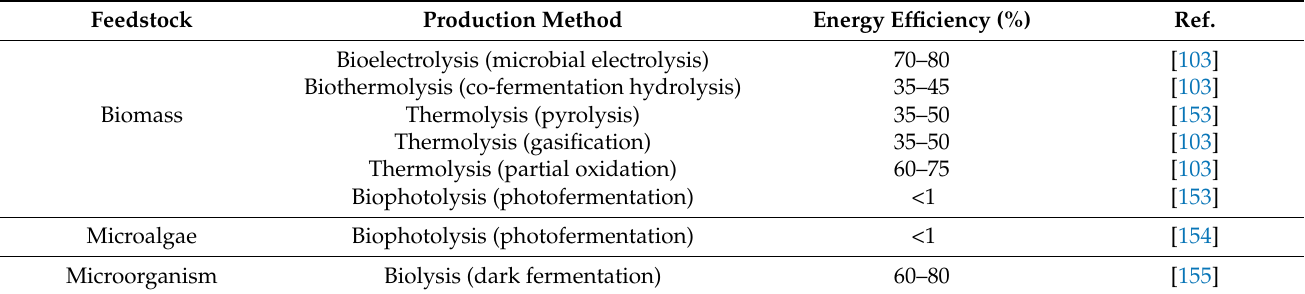
Table 4. Methods for hydrogen production and their efficiency.